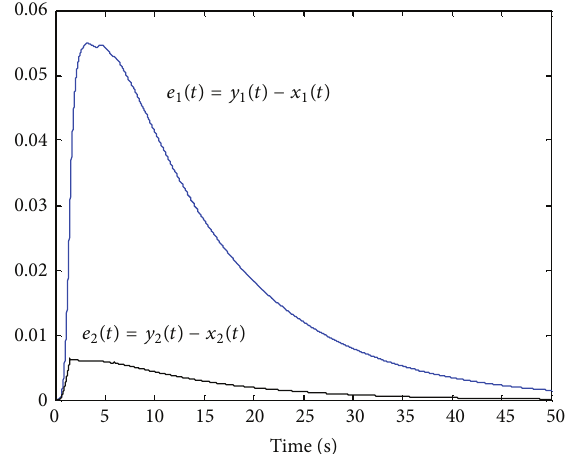
Figure 4: Error between the actual system and the approximate model.